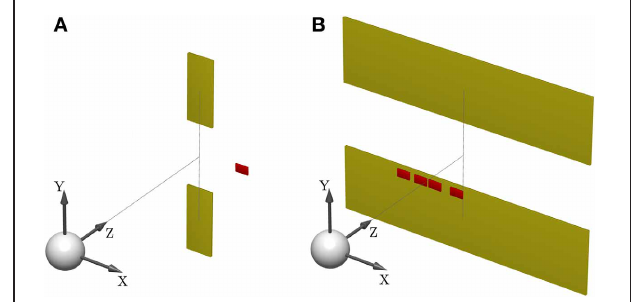
FIGURE 1 | Sensorimotor task setup. (A) Shows the schematic of a standard trial . One of two targets (yellow) has to be hit after observing a shifted cursor (red) for a short feedback duration. The white sphere depicts the start position. (B) Illustrates a probe trial where the visual feedback is ambiguous and consists of a densely sampled array of cursors, centered horizontally and vertically. The target width covers the whole lateral workspace, in order to make horizontal compensations obsolete. A photograph of the experimental apparatus is provided in Figure 15